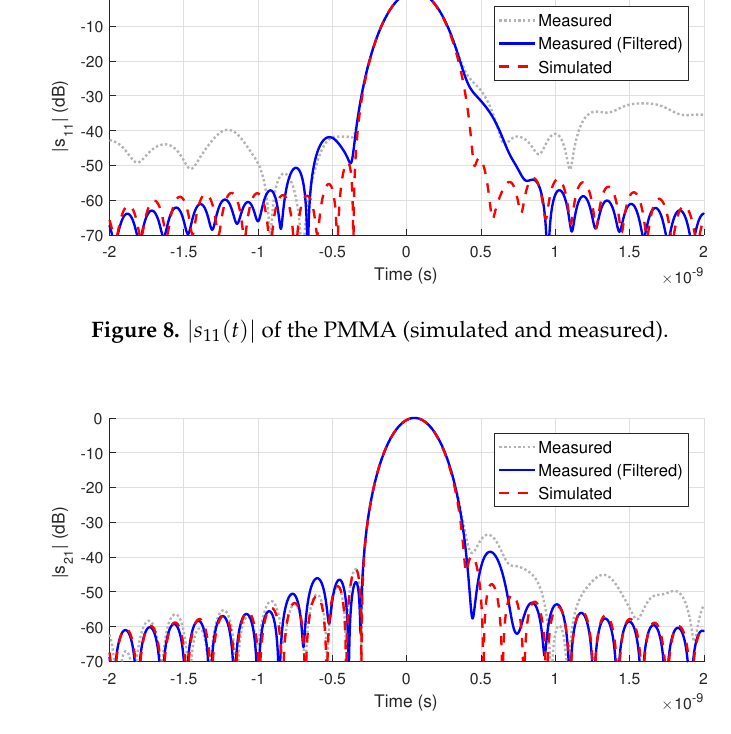
Figure 9. | s 21 ( t ) | of the PMMA (simulated and